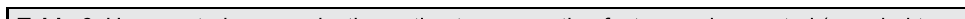
Table 6. Uncorrected pup production estimates, correction factors and corrected (rounded to the nearest 100) pup production estimates for surveys in January 2000. Owing to limited ice, some pups were born on the beach, at Mabou, near Pt. Hood (Fig. 2). These animals were counted from the air in the same way that aerial island counts were completed. Correction fac- tors were not applied to island and shore counts. Standard errors are in